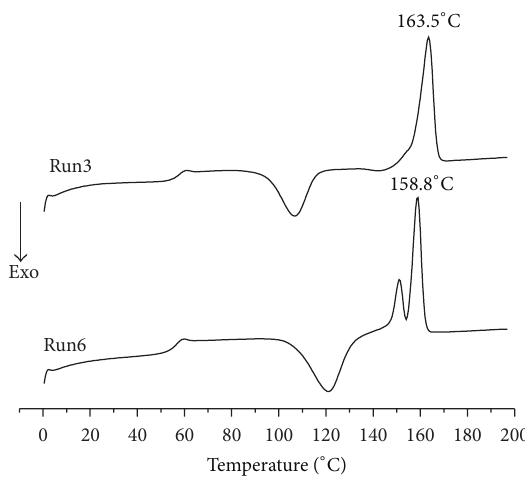
Figure 6: DSC thermogram of the chain-extended PLA with different chain-extending reaction time.